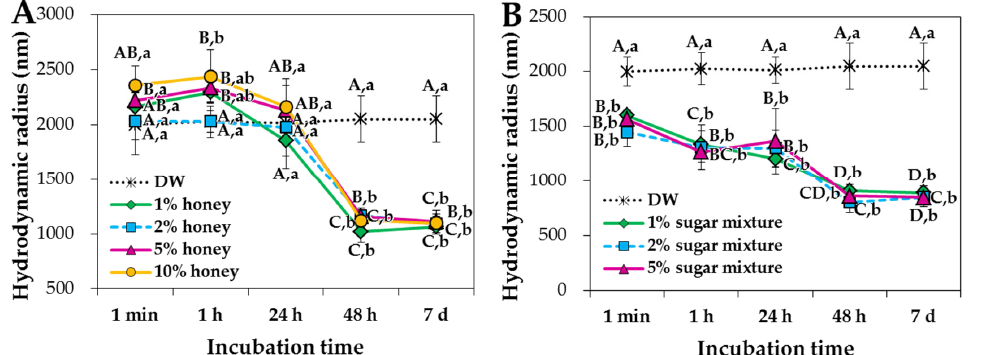
Figure 2. Hydrodynamic radii of ZnO NPs in different concentrations of ( A ) honey and ( B ) sugar mixtures. Different capital letters (A–D) indicate significant differences between incubation times at the same concentration ( p < 0.05). Different lower-case letters (a,b) indicate significant differences between concentrations after the same incubation time ( p < 0.05). Sugar mixtures consist of equivalent amounts of fructose, glucose, sucrose and maltose.